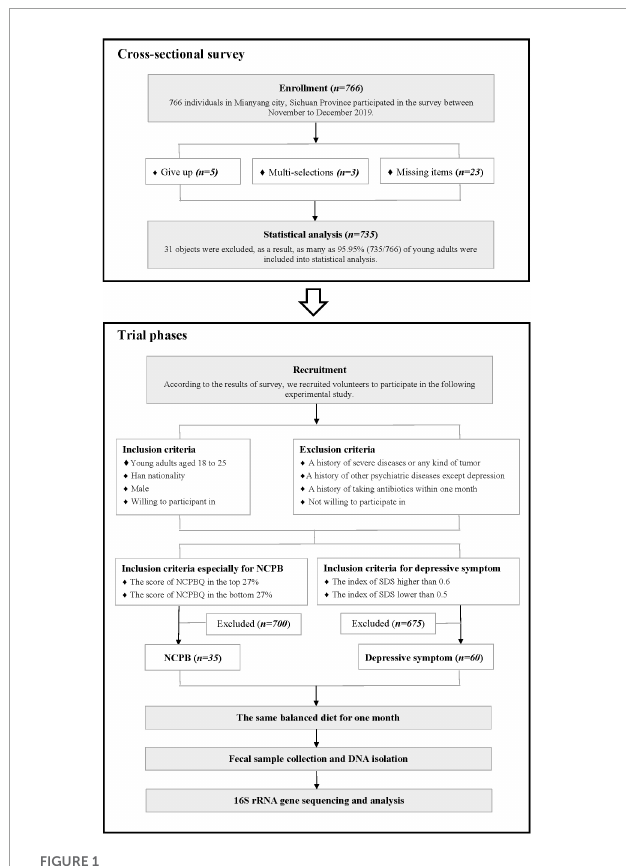
FIGURE1 Flow diagram of the study. HS group, the high-status NCPB group; LS group, the low-status NCPB group; D group, the depression symptom group; C group, the control